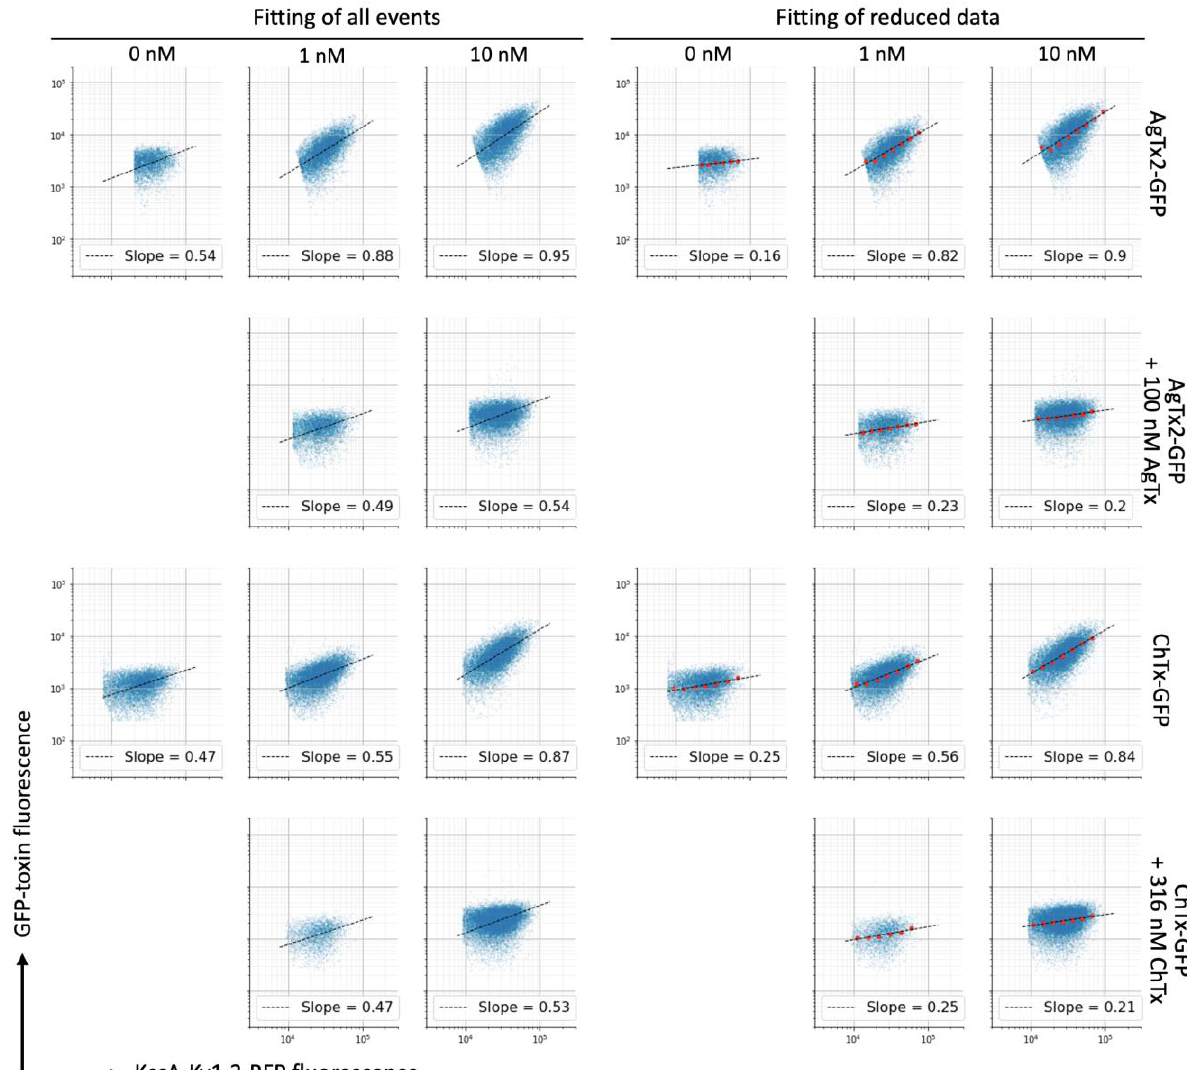
Figure 3. Analysis of a fraction of an occupied receptor from flow cytometry data. Two strategies are presented: fitting of all cells ( left panel) and fitting or reduced data ( right panel). Reduced data are calculated as a maximum of normal cell distribution along the FL1-GFP axis within the narrow window of RFP intensity and presented as red dots. Fitting was done with linear functions. Slopes of the fitted lines (that are proportional to the occupied receptor fraction) are presented on each plot. In the first and third rows, direct binding of AgTx2-GFP and ChTx-GFP at indicated concentrations are presented. The second and fourth rows show nonspecific binding of labeled toxins at the excess of unlabeled counterparts.